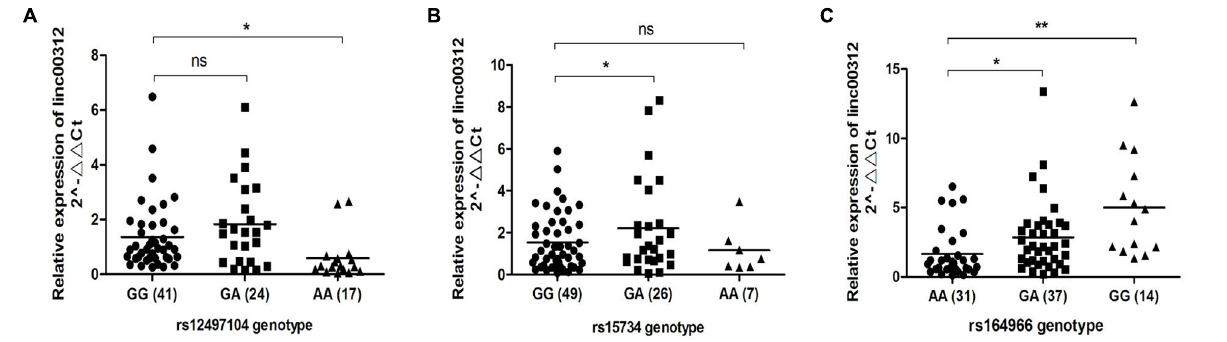
FIGURE 2 | Genotype-specific expression effect of the candidate SNPs. (A) The relative expression of linc00312 in different rs12497104 genotype carriers. (B) The relative expression of linc00312 in different rs15734 genotype carriers. (C) The relative expression of linc00312 in different rs164966 genotype carriers. * P < 0.05; ** P <